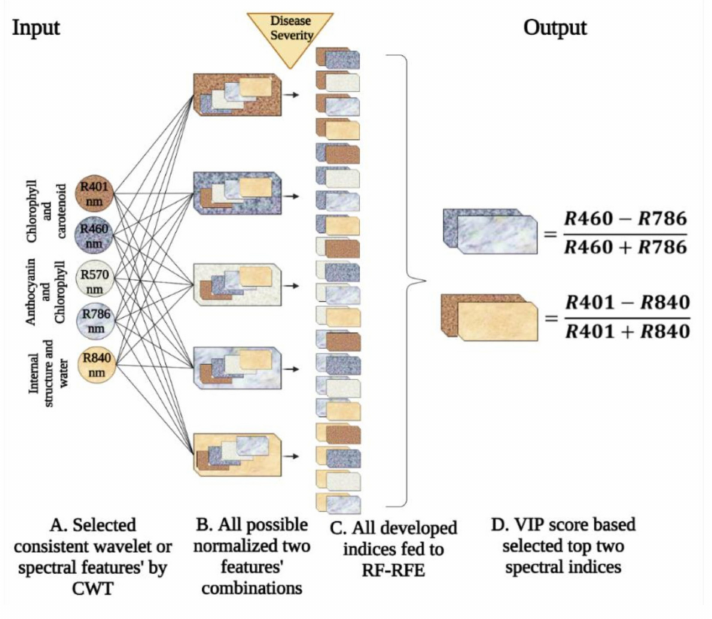
Figure 6. Illustration of workflow for spectral indices development. ( A ): Continuous wavelet analysis (CWT)-based selected five spectral wavelengths (R)—spectral bands—are used as input. ( B ): All possible normalized two features combination-based indices are developed. ( C ): All developed or calculated indices are fed to random forest-recursive feature elimination (RF-RFE) to check the most significant indices for fusarium head blight (FHB) detection or classification. ( D ): Based on classification performance RF-RFE rank indices using variable importance score (VIP), here two most sensitive and robust indices are shown (to interpret colored references in given figure legends, the reader is referred to consult the article’s web